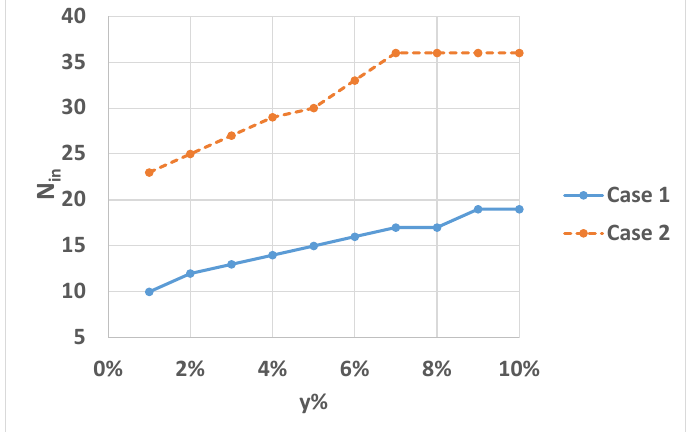
Figure 5. Variation of the optimal N in in terms of the churn rate y : case 1 versus case 2.